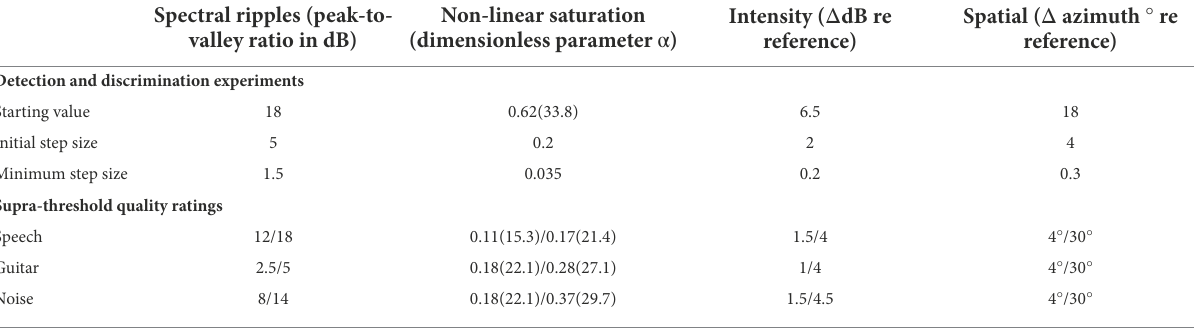
TABLE 1 Experimental parameters (and units) controlling the amount of distortions (columns) in the detection and discrimination experiments and for the quality rating experiments (mild/moderate). Spectral ripples (peak-to- valley ratio in dB)